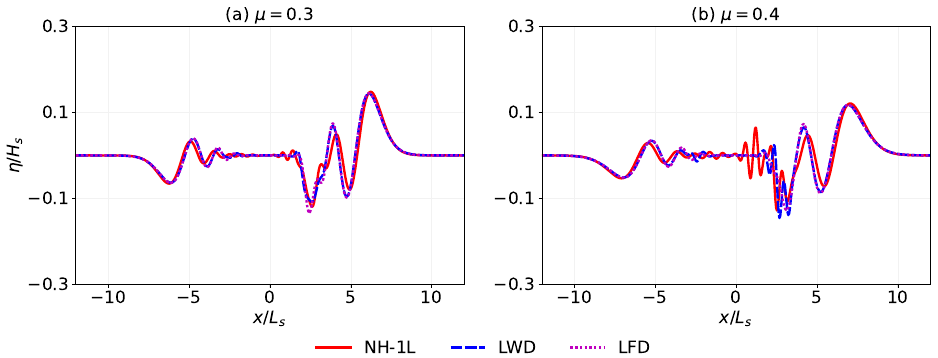
(cid:112) g / L s = 12 resulting from the NH-1L simulation are Figure 7. The free surface profiles at time t compared with the LWD and LFD models for two dispersion parameters ( a ) µ = 0.3. ( b ) µ =